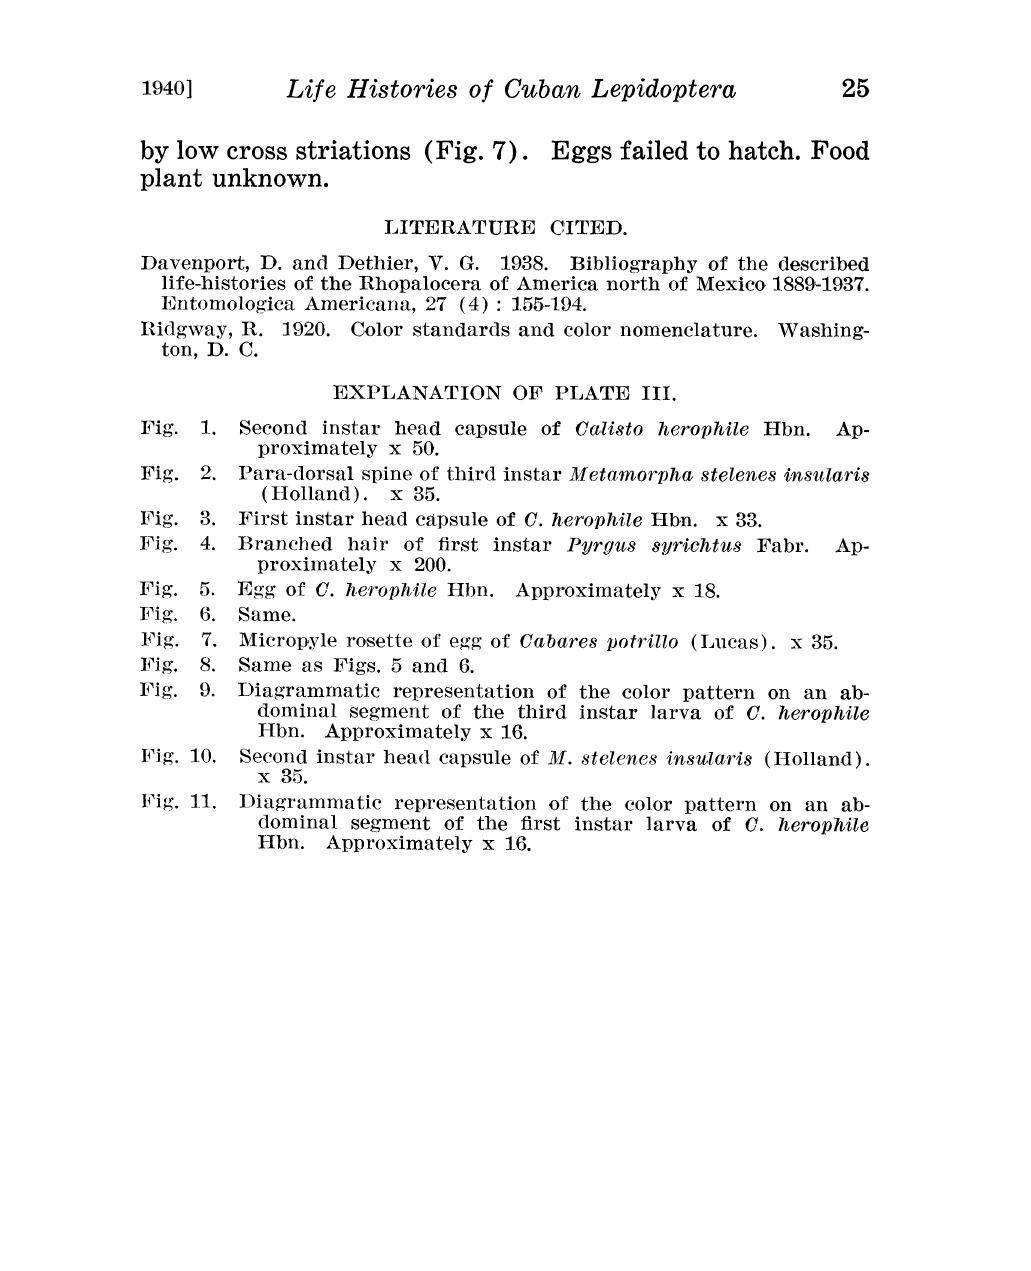
EXPLANATION OF PLATE